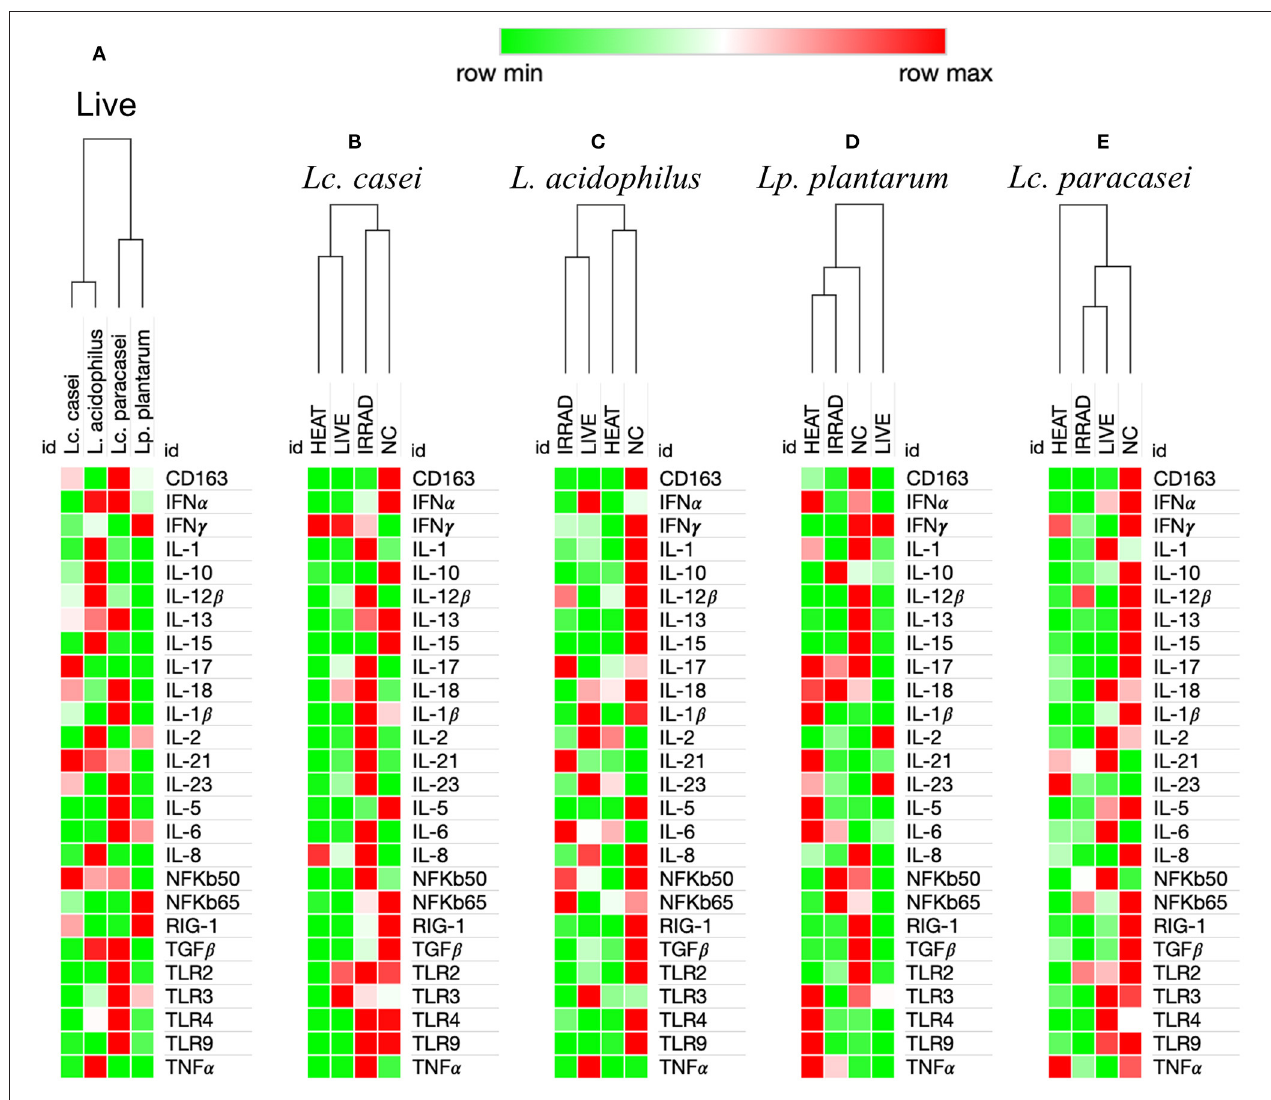
FIGURE 3 | Heat maps analysis of gene expression regulation of 26 immune markers in porcine PBMCs induced by viable and nonviable lactobacilli. Degree of similarity based on one minus Pearson correlation hierarchical clustering in the immune modulation exerted by LAB on the up-(red) or downregulation (green) of 26 immune markers in porcine peripheral blood mononuclear cells. This analysis was performed based upon 11 C t differences among the four live lactobacilli strains (A) , and based upon 1 C t differences among PBMCs unstimulated (NC) and stimulated with live, gamma-irradiated, and heat-treated Lacticaseibacillus casei (B) , Lactobacillus acidophilus (C) , Lactiplantibacillus plantarum (D) , and Lacticaseibacillus paracasei (E) . Values in the heat map are mapped to colors using the minimum and maximum of each row